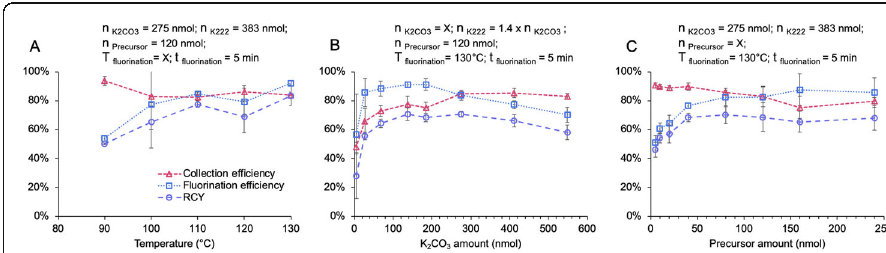
Fig. 3 Optimization summary of fluorination step. For all reactions, [ 18 F]Fluoride (aq) was evaporated to dryness with 4.5 μ L of base and phase-transfer catalyst in DI H 2 O, then reacted with 20 μ L precursor in DMSO for 5 min. The resulting product was analyzed via radio-TLC. a Effect of temperature on reaction performance; b Effect of base amount on the reaction (K 222 amount is 1.4x that of K 2 CO 3 ); c Effect of precursor concentration on the reaction. Data points represent the average of n = 4 repeat measurements, and error bars represent standard deviations. In each panel, the changing variable is listed with an “ X ” (above the graphs), and the fixed values of all other parameters are as indicated. The legend from A applies to all